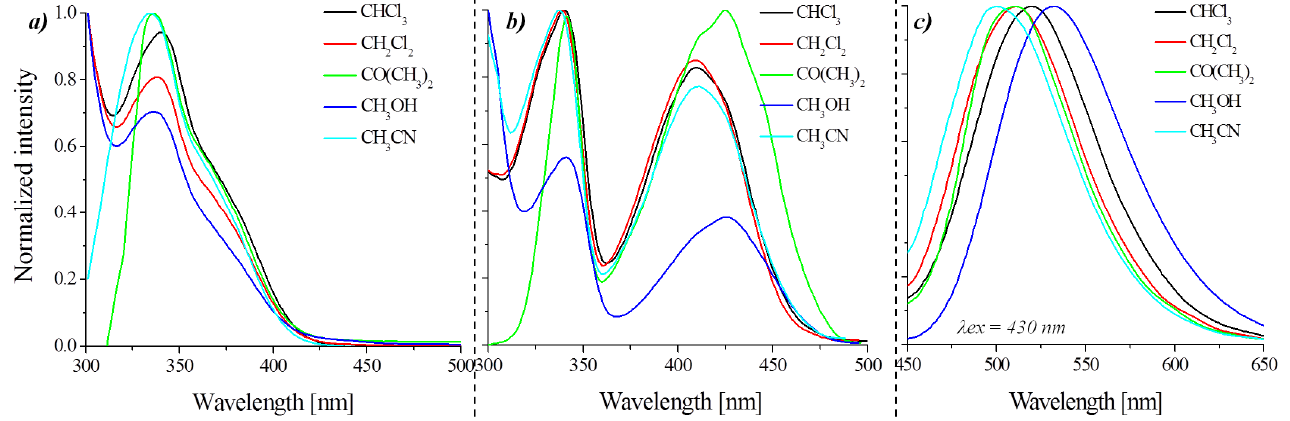
Figure 3. The ( a ) absorption, ( b ) excitation, and ( c ) emission spectra of AzNI–2 in various solvents. Table 4. The position of the electroluminescence band maximum with its